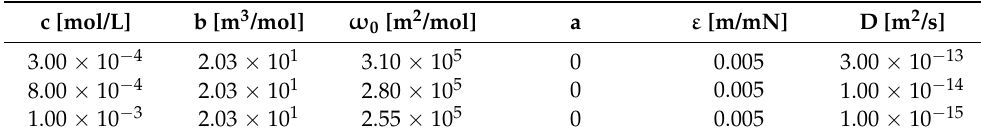
Table 10. Parameter values obtained by fitting the Frumkin adsorption model Equations (1)–(3) and the diffusion Equation (6) to the experimental data of Figure 10 as measured for equimolar solutions of NaC 6 SO 4 + C 6 TAB.